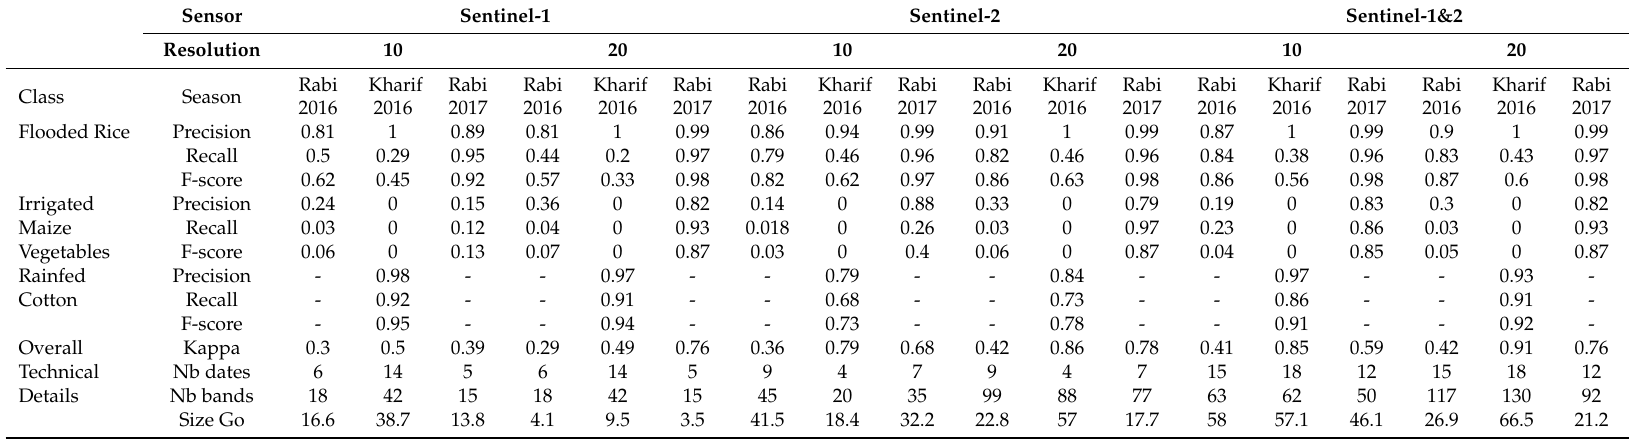
Table 3. Results of Random Forest classification using multi-temporal Sentinel-1 and 2 imagery at 10 or 20 m, for three contrasted growing seasons: Rabi 2016 (December to March 2016), Kharif 2016 (July to November 2016), and Rabi 2017 (December to March 2017). Precision and recall respectively stand for the predicted fraction of pixels classified as the appropriate class and the fraction of validation pixels that have been correctly classified. The F-score is the harmonic mean of both metrics and evaluates the relevance of the classifier. The Kappa index is an estimation of this relevance for all nine crop classes considered: rice, vegetable, maize, forest, orchard, bare ground dry areas or bush, urban area, water, and cotton (if any). Technical details on the size of images stacks are detailed.